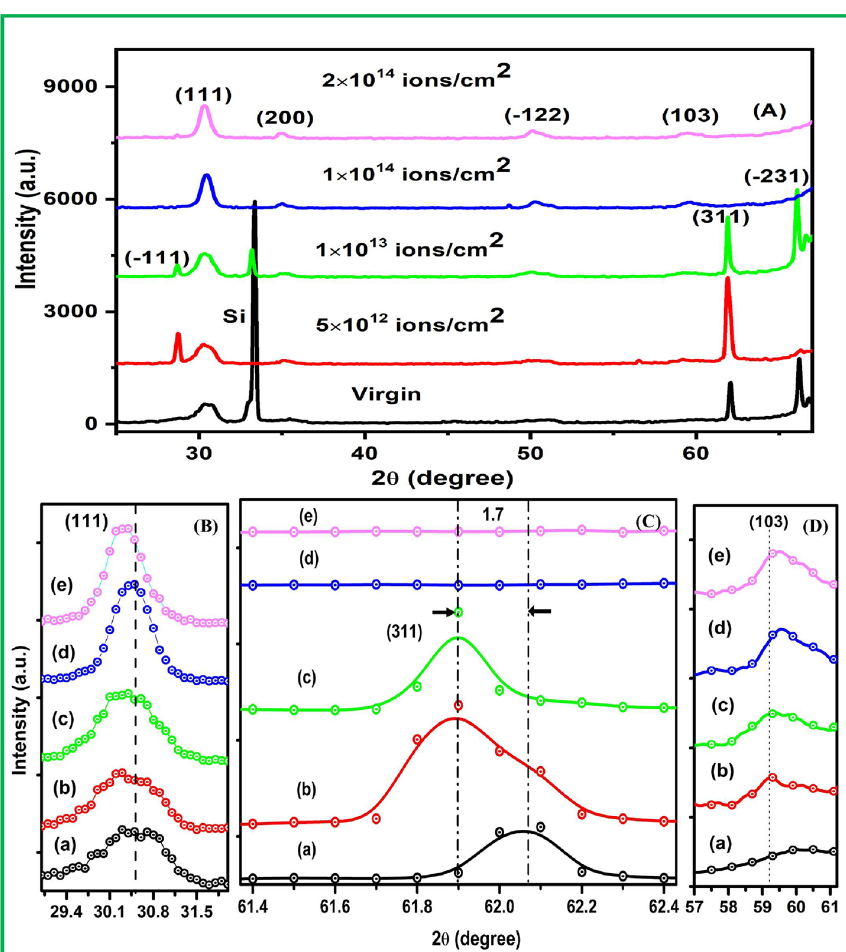
Figure 2. X-ray diffraction pattern ( A ) ZrO 2 virgin and irradiated samples showing the crystalline nature (monoclinic and tetragonal structure), the magnified image of the reflection planes ( B ) (111) shows peak shifting towards lower angle, also ( C ) plane (311) shows the shifting of peak towards lower angle and ( D ) (103) plane shows the phase transformation (monoclinic to tetragonal) of ZrO 2 thin films when (a) virgin samples irradiated with Ni ion using fluence (b) 5 × 10 12 (c) 1 × 10 13 (d) 1 × 10 14 and ( e ) 2 × 10 14 ions/cm 2